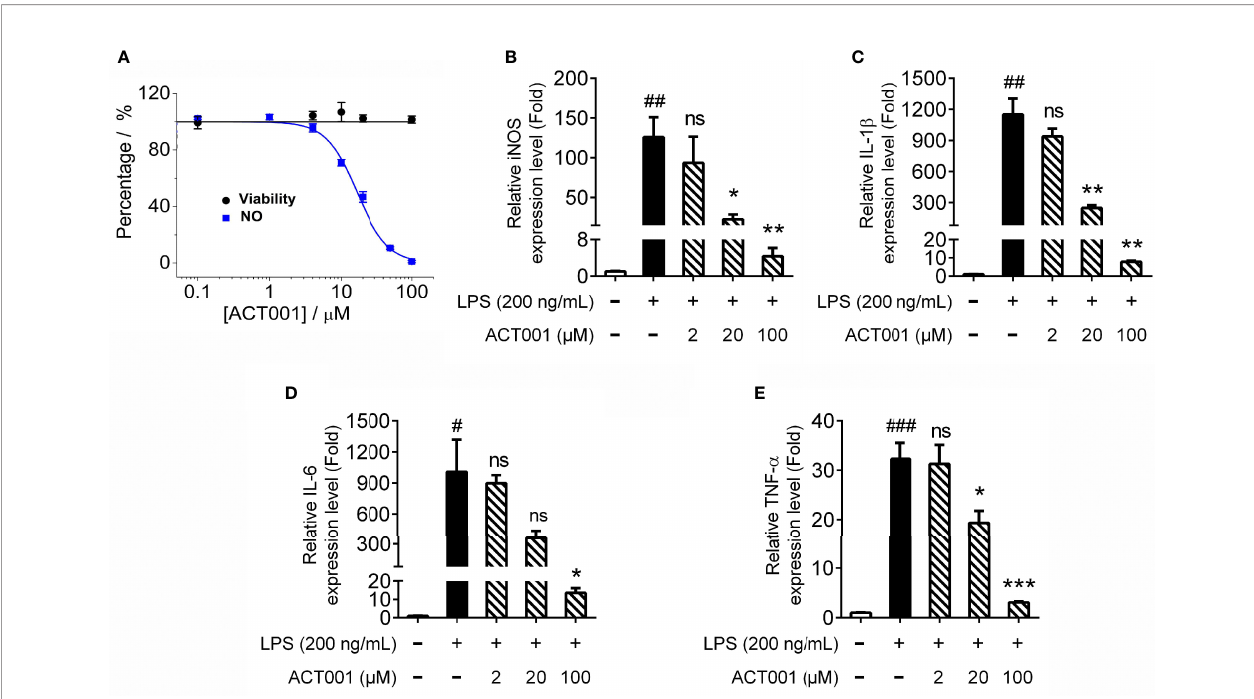
FIGURE 5 | ACT001 inhibits LPS-induced pro-in fl ammatory factors overproduction. (A) BV-2 cells were administered with LPS and indicated concentrations of ACT001. After 24 h incubation, the effects of ACT001 on LPS-induced NO and cellular viability were measured. (B-E) BV-2 cells were administered with 200 ng/mL LPS and indicated concentrations of ACT001. After 6 h incubation, the effects of ACT001 on LPS induced iNOS (B) , IL-1 b (C) , IL-6 (D) and TNF- a (E) mRNA were measured. All the data represented the mean ± SEM; n, number of independent cell culture preparations = 3. # P< 0.05, ## P< 0.01, ### P< 0.001 versus the control; *P< 0.05,**P< 0.01, ***P< 0.001 versus the LPS group; ns, not signi fi cant.